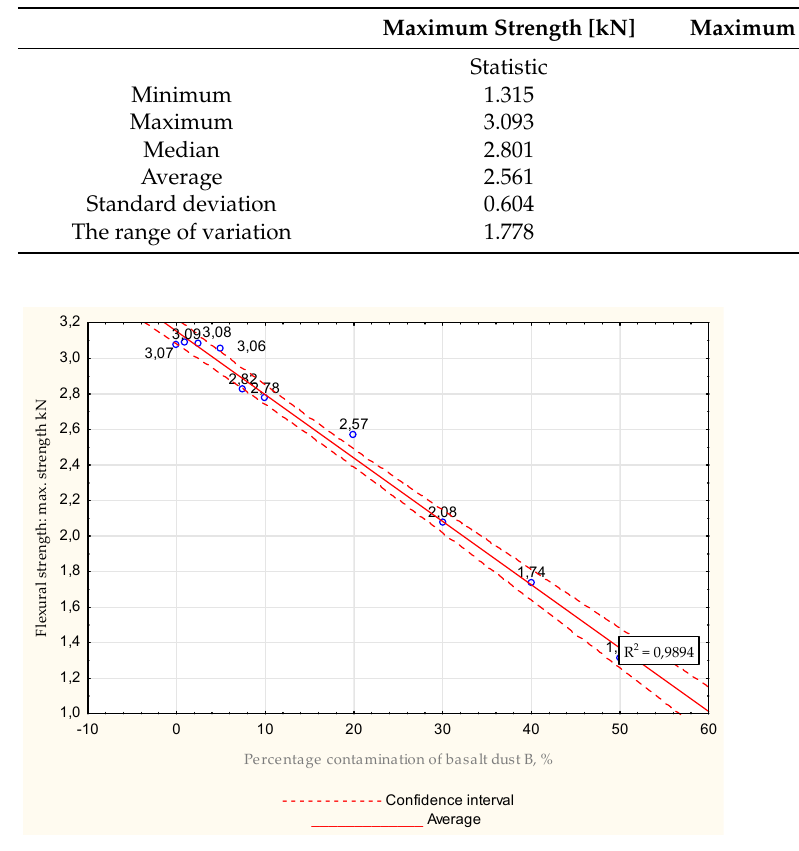
R 2 = 0,9933 Figure 32. Average values obtained during flexural strength tests after 28 days for water − mix ratio = 0.6, maximal pressure.